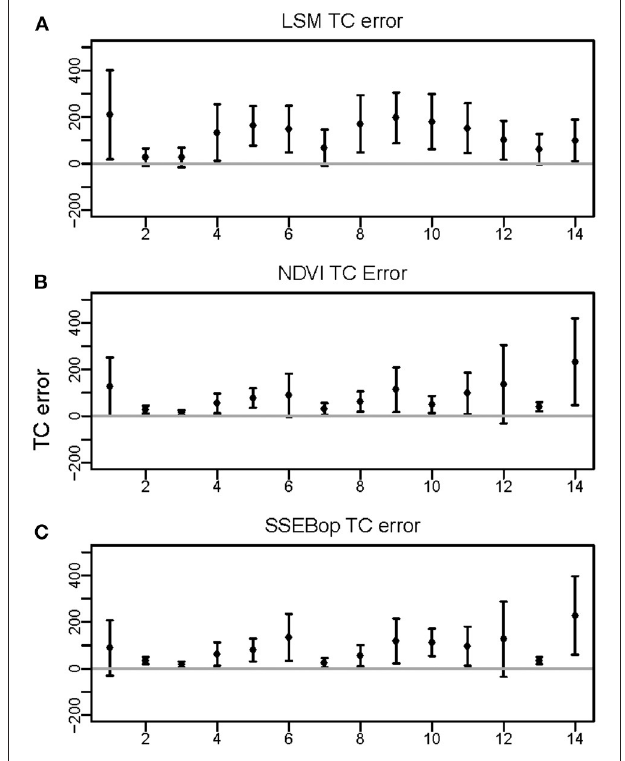
FIGURE 10 | Average TC error by land cover type for (A) LSM ET TC error, (B) NDVI TC error, and (C) SSEBop ET TC error. The corresponding vegetation type for the numbers along the x-axis are shown in Table 1 .